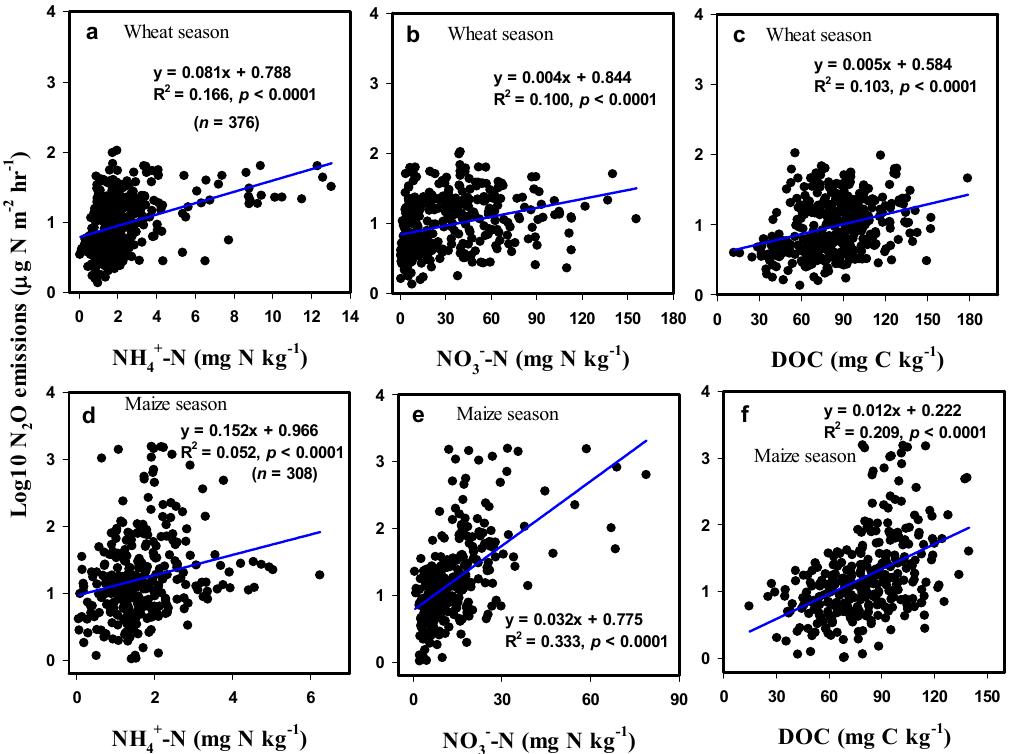
Figure 9. Relationships between N 2 O emissions and NH 4 + -N, NO 3 − -N, and DOC content and soil in the wheat season ( a – c ) and in the maize season ( d – f ) for the wheat and the maize seasons across the four treatments over the two-year period from 2016 – 2018.